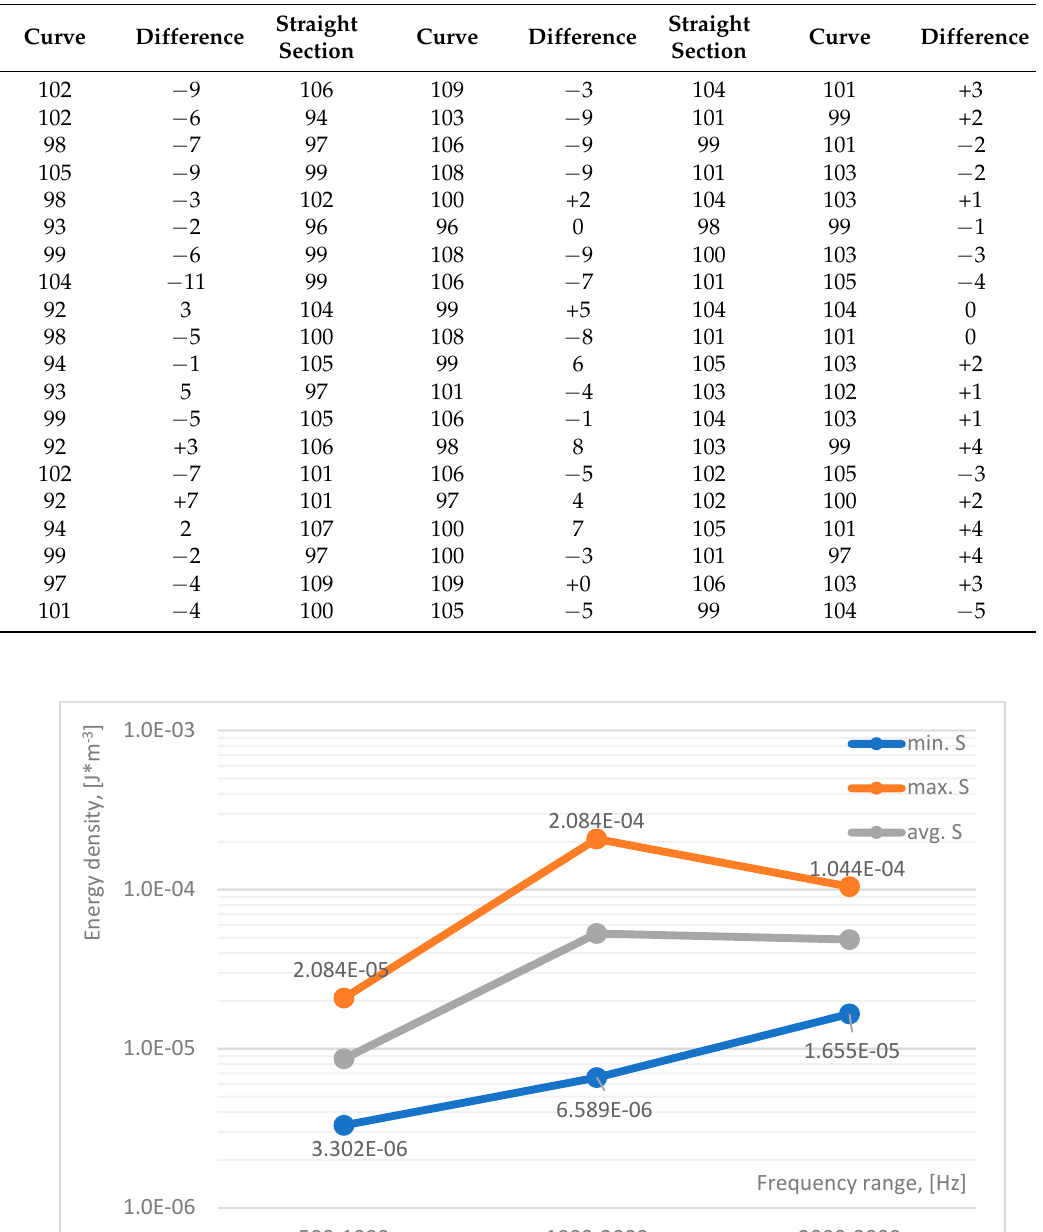
Figure 17. The average value of the total acoustic wave energy density for the curved track at a speed of 200 km/h. The conducted tests showed an increase in the density of acoustic energy in the fre- quency range 500–2000 Hz in the case of driving on a curved track and an increase in the density of acoustic energy in the frequency range of 2000–3000 Hz in the case of driving on a straight track. Experimental research made it possible to determine which type of noise (rolling or aerodynamic) constituted the main source. The research confirmed that in the case of elec- tric multiple traction units traveling at a speed of 200 km/h, the rolling noise, resulting from vibrations generated from wheel-rail contact, was the dominant source of noise. In the case of high-speed railway vehicles traveling along a curve with a radius of about R = 4000 m, the noise resulting from wheel-rail vibrations did not have a clear impact on in- creasing the maximum sound levels compared with a straight section. Experimental tests carried out under the described conditions showed the dominance of high-frequency levels, i.e., 1.0–3.0 kHz for the straight path, and an increase in sound pressure levels, at frequencies of 0.5–1.0 kHz, for the path following the curve. In addition,